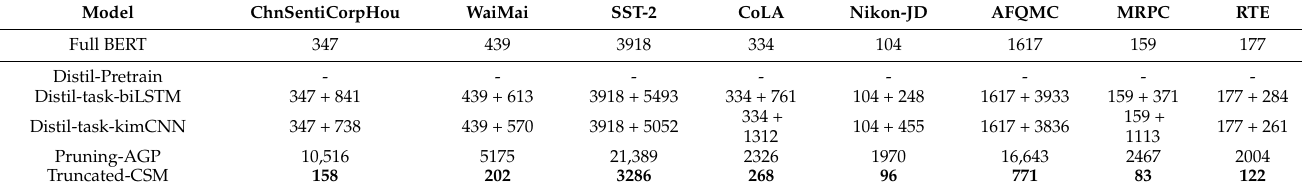
Table 7. Training time (s) for the 8 BTC tasks in this study. Bold denotes the shortest times. For distillation-based method, it includes fine-tuning time of teacher model and distillation time of student model. For pruning methods, it includes fine-tuning time and weight pruning time, whereas for truncation-based method, it includes calculation time of separability measure and fine-tuning time. Note that the total training time of Distil-Pretrain is not available, and hence not given